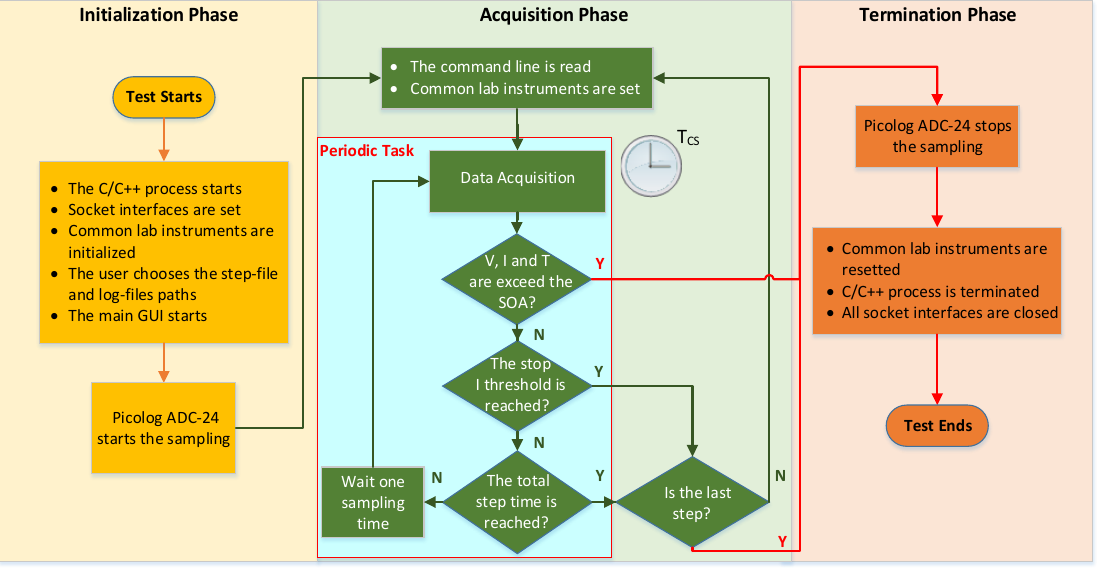
Figure 5. Flowchart of the software process written in Python.